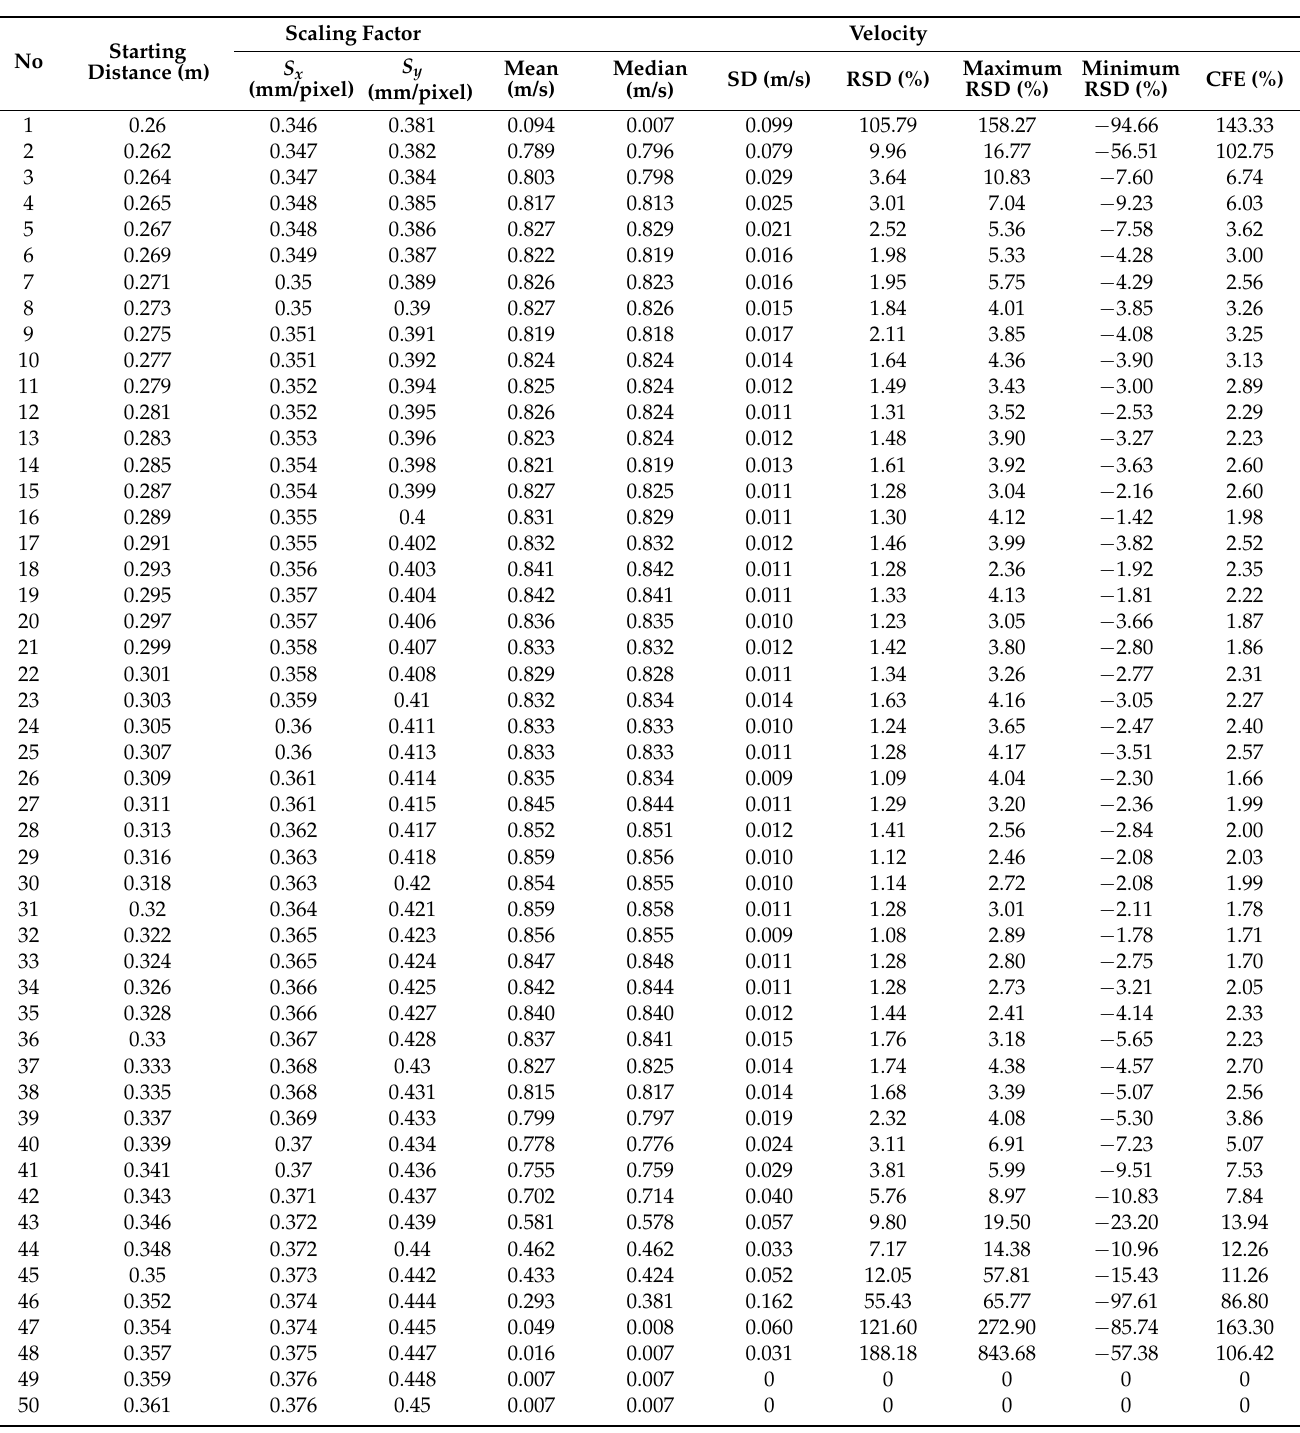
Table 7. Statistical results of velocity